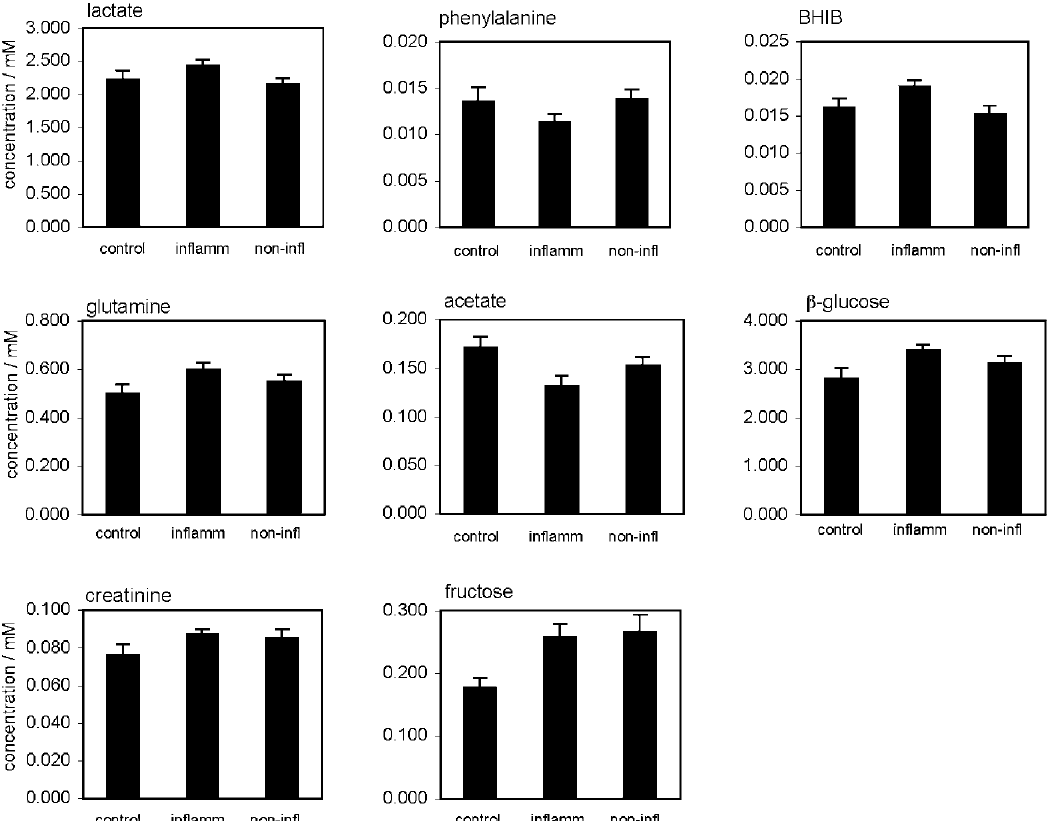
Figure 1. Selected CSF metabolite concentrations [mM] in patients with or without inflammatory brain MS plaques (abbreviated ‘inflamm’ and ‘non-infl’, respectively), and controls. Data represent means 6 s.e.m.